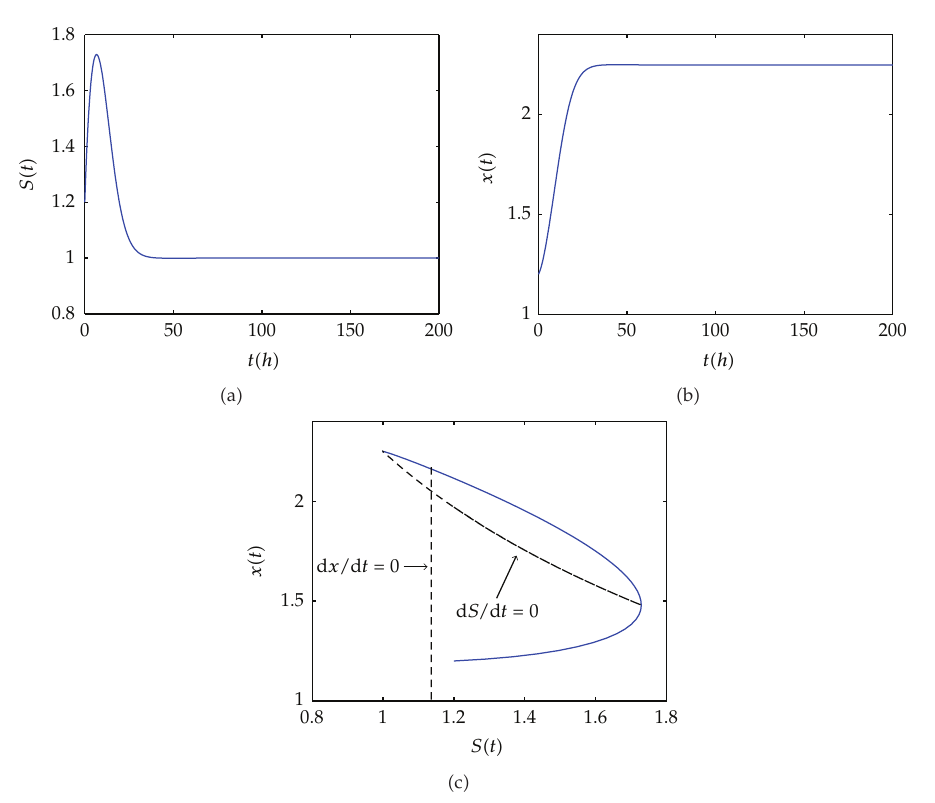
Figure 10: The time series and phase diagram for system (cid:5) 2.6 (cid:6) starting from initial point (cid:5) S 0 ,x 0 (cid:6) (cid:7) (cid:5) 1 . 2 , 1 . 2 (cid:6) with a (cid:7) 2, b (cid:7) 1 . 5, and x set (cid:7) 2 . 5 (cid:3) g/l (cid:4)